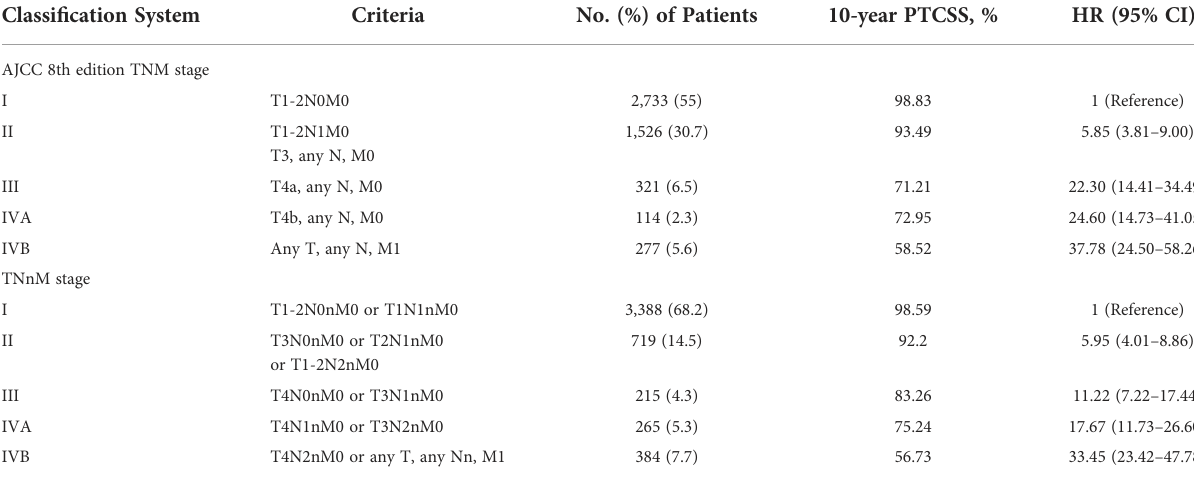
TABLE 3 Survival for AJCC 8th edition TNM and TNnM staging systems for patients aged ≥ 55 years with papillary thyroid cancer. Classi fi cation System